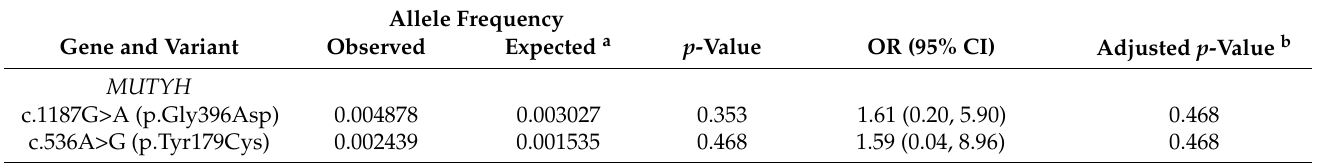
Table 4. Hereditary predisposition gene mutations, observed allele frequencies in University of Kentucky family medicine patients, and expected global population allele frequencies. Allele